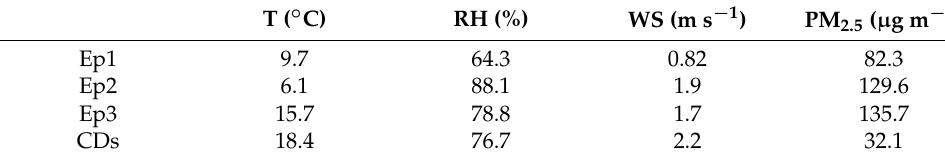
Figure 6. Horizontal ground meteorological conditions during EG. Table 1. Meteorological factors and PM 2.5 concentration during CDs and EG.